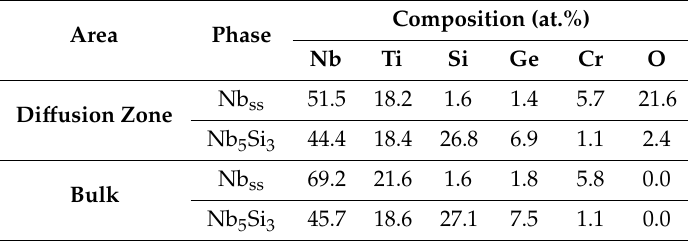
Table 3. The Electron Microprobe Analysis (EPMA) data of the constituent phases in the diffusion zone and bulk of the oxidised alloy ZF4. Composition (at.%) Area Phase Nb Ti Ge